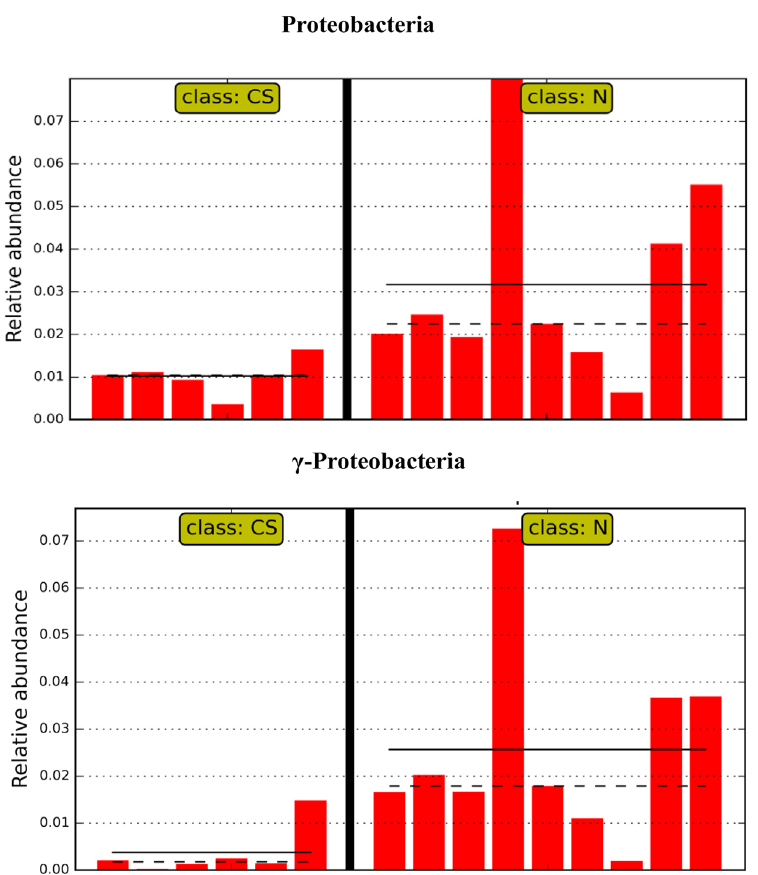
Figure 7. Microbial taxa significantly impacted by CS disaccharides in healthy mice. ( A ) Proteobacteria. ( B ) γ -Proetobacteria. N: healthy mice + PBS; CS: healthy mice supplemented with a daily dose of 150 mg/kg bodyweight of CS disaccharides for 16 days. Straight line: group mean abundance. Dotted Line: